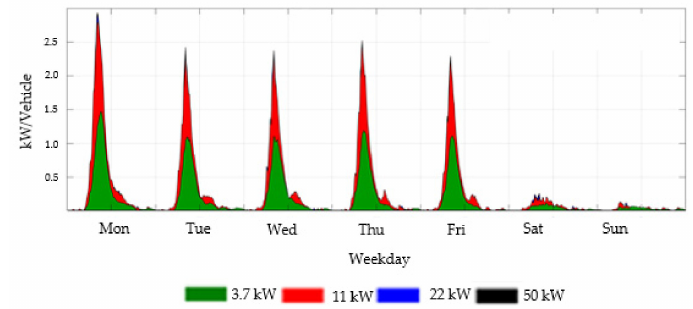
Figure A18. Charging Patterns for uncontrolled charging for “workplace charging”. If both home charging and workplace charging were included in the charging pro- cesses, it resulted in the load profile illustrated in Figure A19. However, this charging pattern did not resemble any of the above user groups.